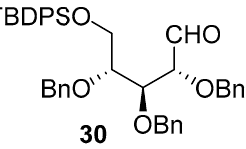
Figure 10. The structure of aldehyde 30.